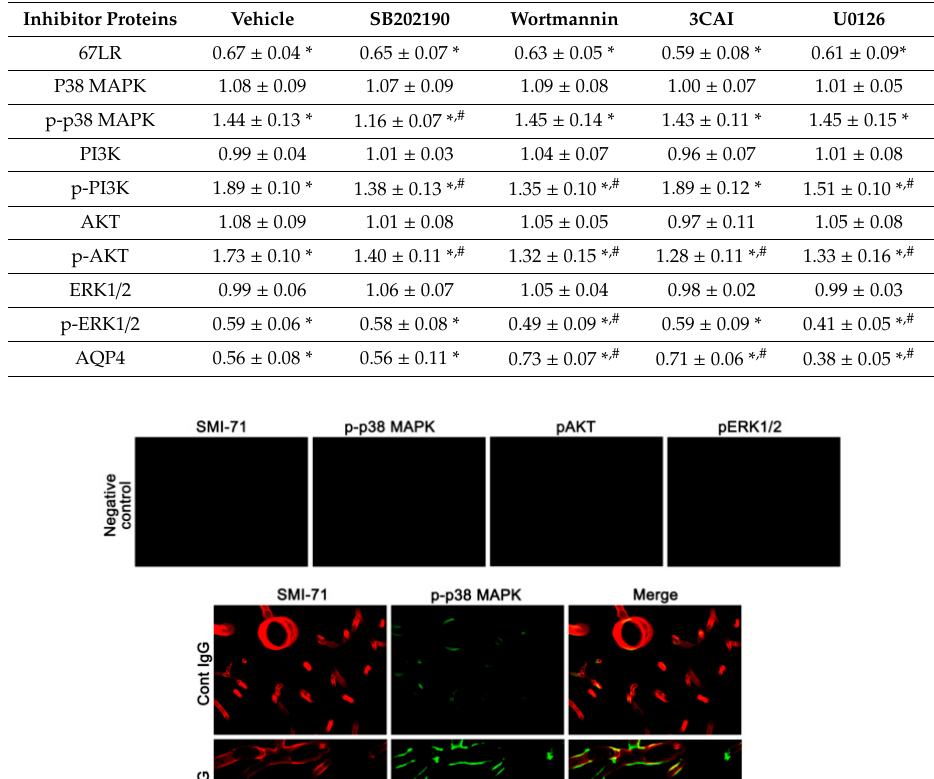
Table 3. Densities (mean ± S.D. fold of control animal level) of 67LR, total kinases, phospho (p)-kinases, and AQP4 in the PC of SE-induced animals (* ,# p < 0.05 vs. control animal and vehicle, respectively).